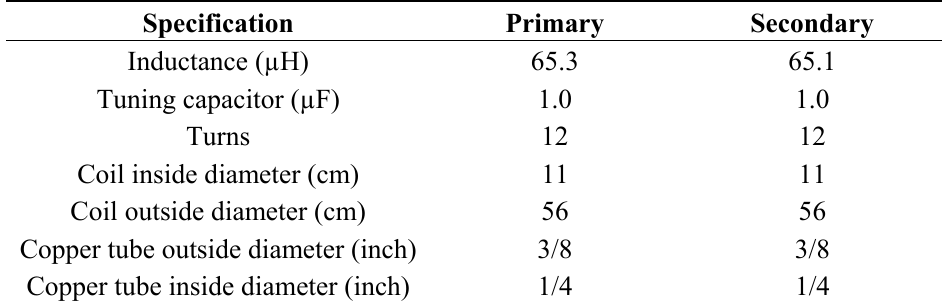
Table 1. Parameters of transmitter and receiver coils.